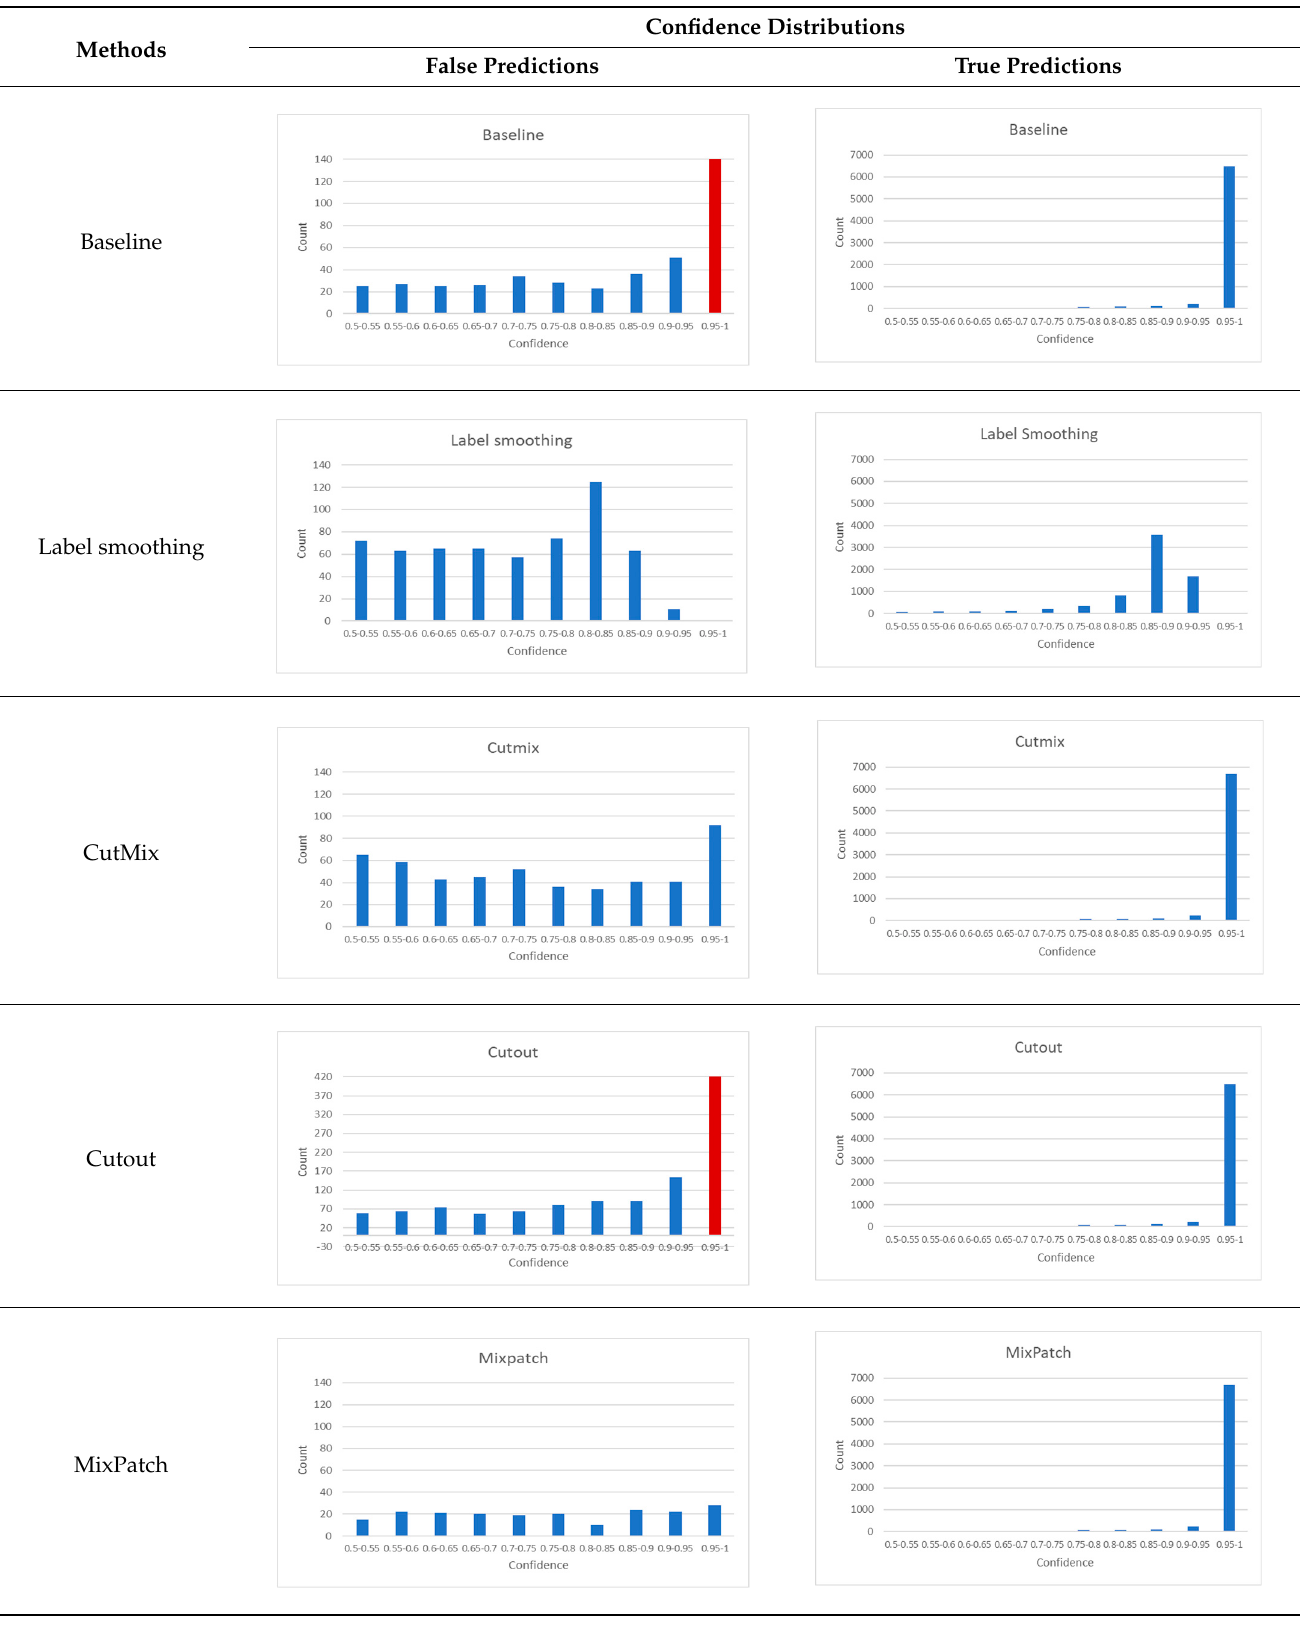
Table 6. Confidence distributions of each method.